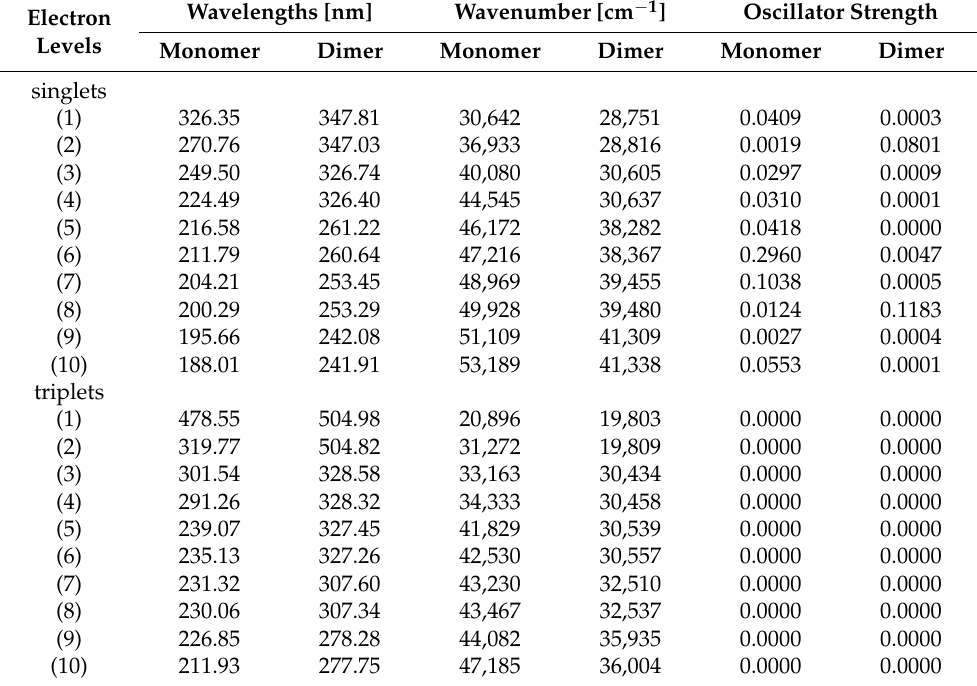
Table 4. Calculated singlet and triplet electron levels of the TPa-NH 2